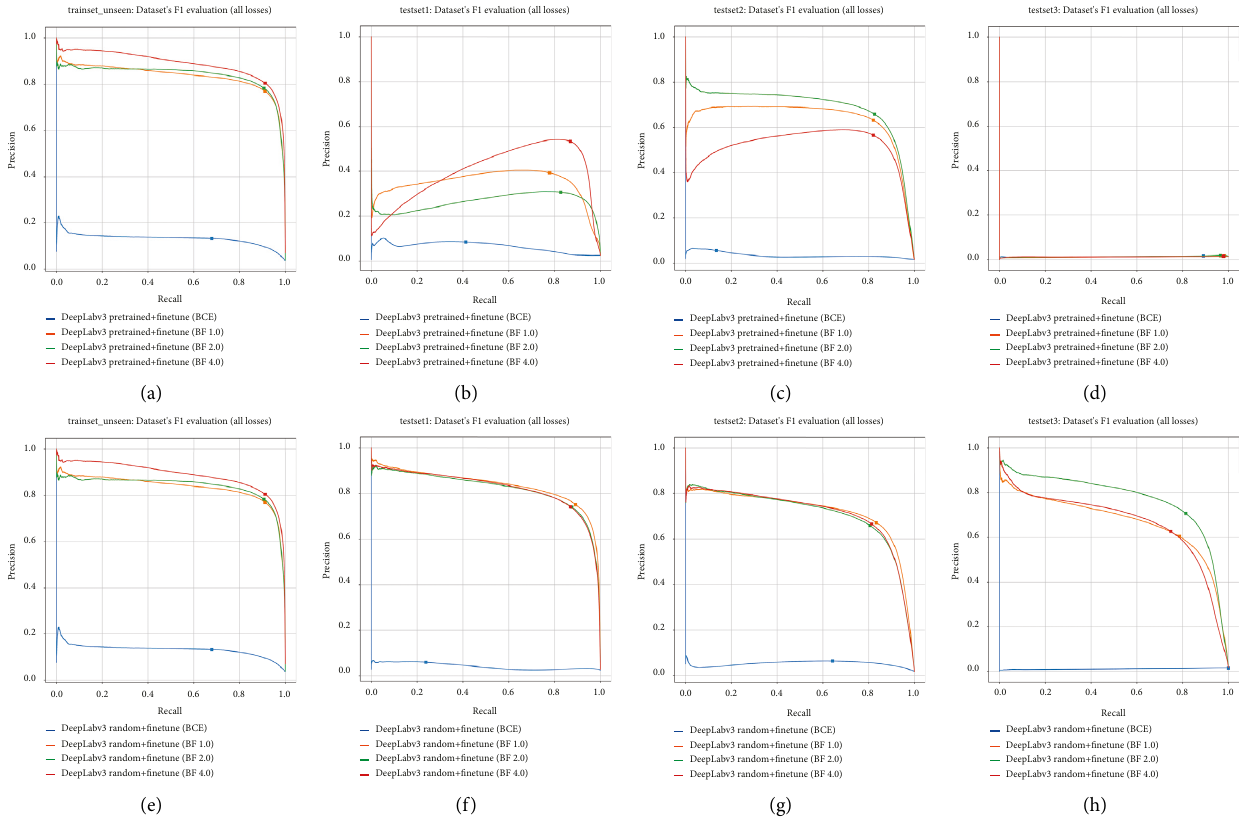
Figure 3: The precision-recall curves regarding our downstream models built upon DeepLabV3-ResNet101. The best F-measure (ODS F- measure) of each graph is marked with a small rectangle. (a–d) and (e–h) represent two training strategies which are training from the pretrained weights and training from random weights, respectively. Testing results are shown for CrackTree260 in (a, e), CRKWH100 in (b, f), CrackLS315 in (c, g), and Stone331 in (d,